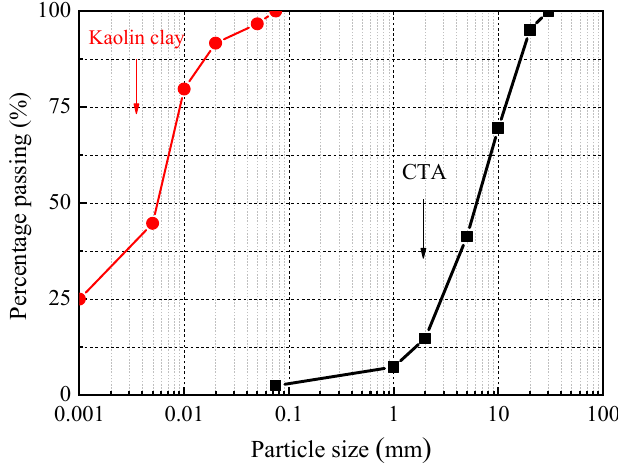
Figure 1. The gradation curve of CTA and Kaolin clay.